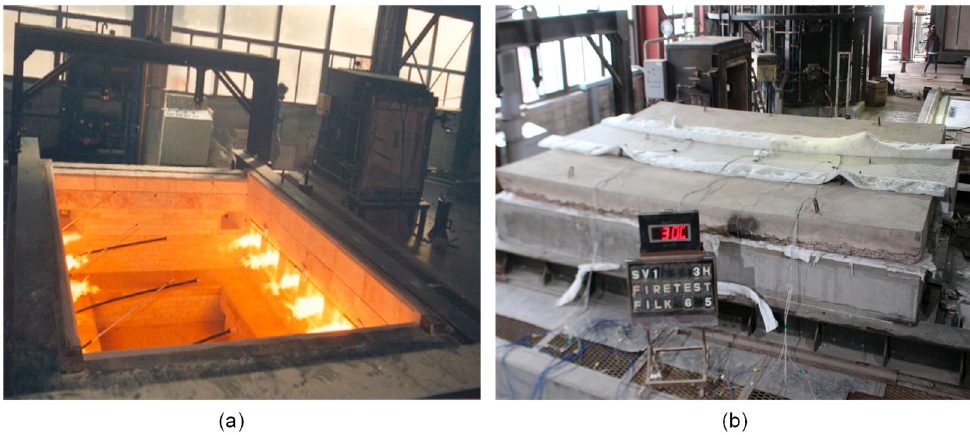
Figure 4. A furnace for horizontal building members: ( a ) a chamber in the furnace with eight natural gas burners and three K-type thermocouples for monitoring temperature during fire testing, and ( b ) the concrete slab specimen under standard fire testing.